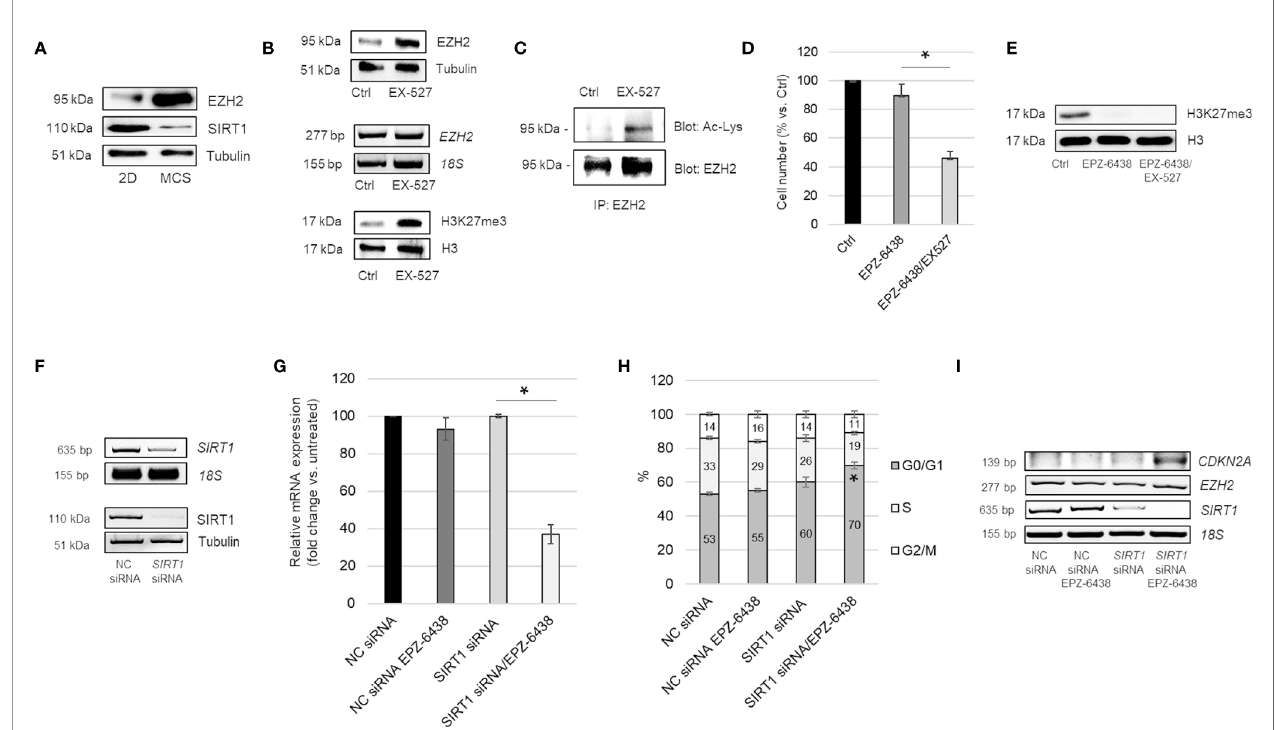
FIGURE 3 | SIRT1 inhibition increases EZH2 expression, acetylation and activity. (A) Representative Western blot analysis of EZH2 and SIRT1 in MSTO-211H cells cultured 48 h as monolayer or as MCS. Tubulin was used as loading control. (B) Representative Western blot analysis and RT-PCR analysis of EZH2 expression and of H3K27 trimethylation (H3K27me3) in MSTO-211H cells cultured as monolayer ± 48 h EX527 treatment. Tubulin and histone H3 were used as loading control and 18S rRNA as housekeeping gene. (C) Immunoprecipitation of EZH2 from lysates of MSTO-211H cells ± EX527 48 h treatment. Lysine acetylation and EZH2 were detected by Western blot analysis with the respective antibodies (AcLys and EZH2). (D) Bar graph shows the percentage of viability of MSTO-211H cells cultured as monolayer ± 48 h treatment with EPZ-6438 or EPZ-6438/EX527 combination. Each bar represents mean of three independent experiments ± s.d., *p ≤ 0.05. (E) Representative Western blot analysis of H3K27me3 in MSTO-211H cells treated 48 h with EPZ-6438 or EPZ-6438/EX527 combination. Histone H3 was used as loading control. (F) Representative Western blot analysis and RT-PCR analysis of SIRT1 expression in MSTO-211H cells transfected with negative control (NC) or SIRT1 speci fi c siRNAs ( SIRT1 siRNA). Tubulin was used as loading control and 18S rRNA as housekeeping gene. (G) Bar graph shows the percentage of viability of MSTO-211H cells transfected with negative control (NC) or SIRT1 speci fi c siRNAs ( SIRT1 siRNA) after 48 h treatment ± EPZ-6438. Each bar represents mean of three independent experiments ± s.d., *p ≤ 0.05. (H) Bar graph representing the percentage of cells in G0/G1, S and G2 phase of MSTO-211H cells transfected with negative control (NC) or SIRT1 speci fi c siRNAs ( SIRT1 siRNA) and treated or not, 48 h, with EPZ-6438. Bars represent the means of three measurements ± s.d., *p <0.05. (I) Representative quantitative RT-PCR analysis of CDKN2A , EZH2 and SIRT1 in MSTO-211H cells transfected with negative control (NC) or SIRT1 speci fi c siRNAs ( SIRT1 siRNA) and treated 48 h ± EPZ-6438. 18S rRNA was used as housekeeping